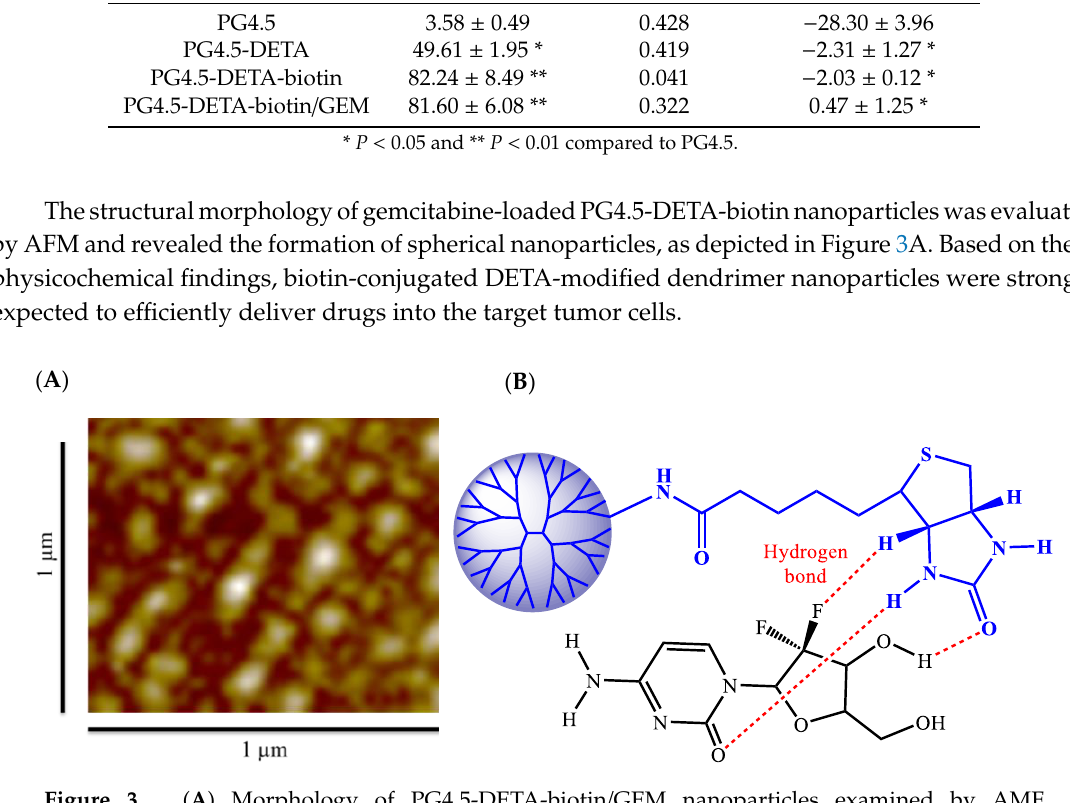
Figure 3. ( A ) Morphology of PG4.5-DETA-biotin / GEM nanoparticles examined by AMF. ( B ) Schematic representation of hydrogen bonding between biotin and gemcitabine in PG4.5-DETA-biotin / GEM nanoparticles.